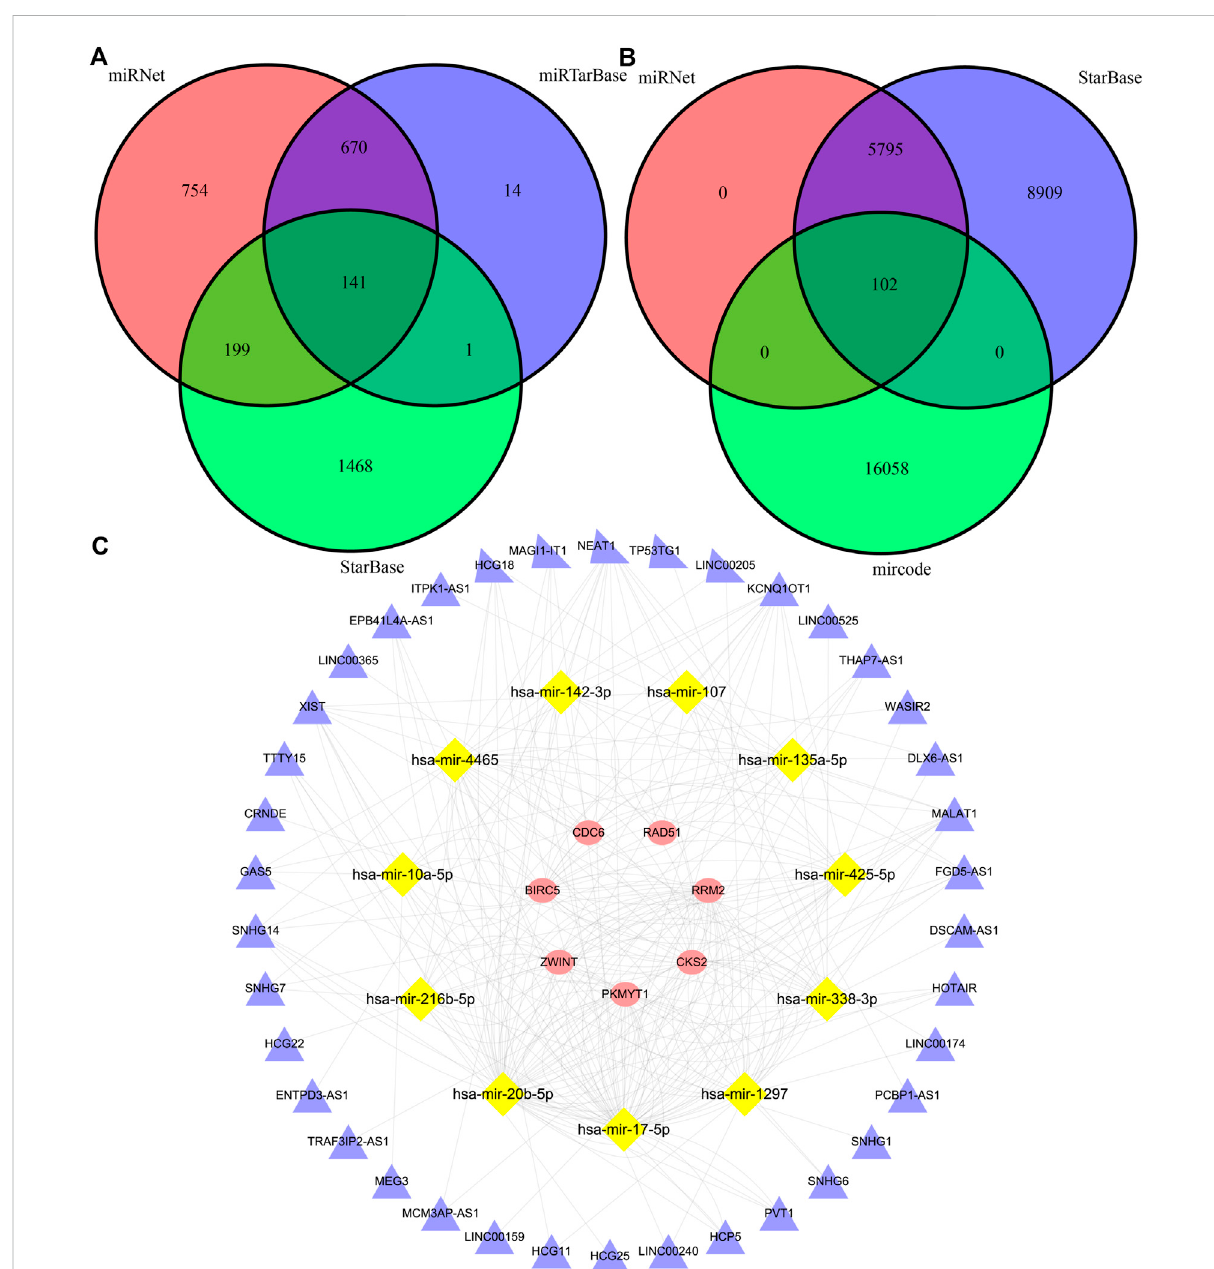
FIGURE 8 The construction of a triple-regulatory network of mRNA-miRNA-lncRNA. (A) miRNAs predicted by miRNet, miRTarBase and StarBase databases. (B) lncRNAs predicted by miRNet, StarBase and mircode databases. (C) mrna-mirna-lncrna regulatory